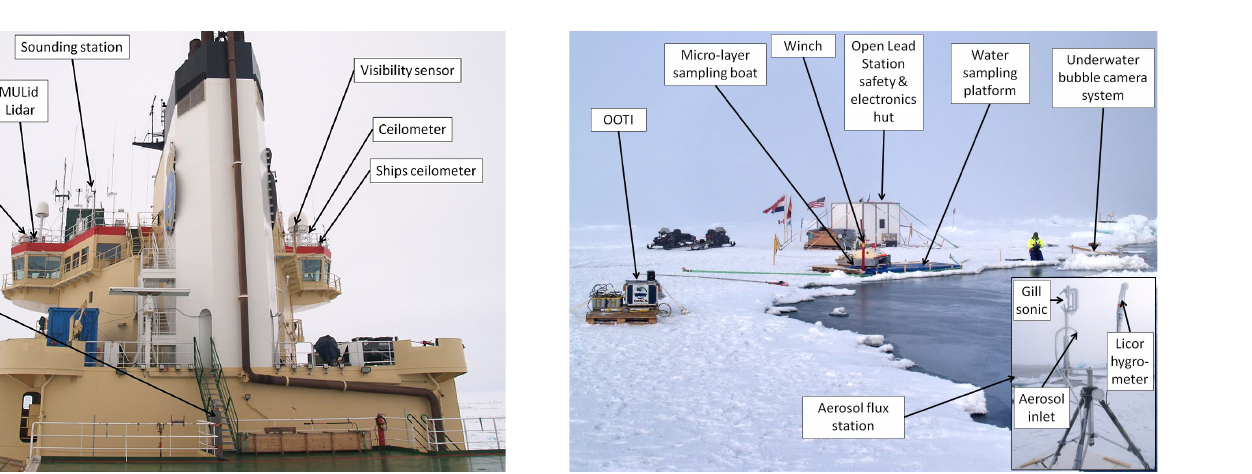
Fig. 7. Photograph of the installations on Oden as seen from the helicopter landing pad, which was also the sounding launch station; also seen are the location for several other instruments at the aft of the seventh deck.